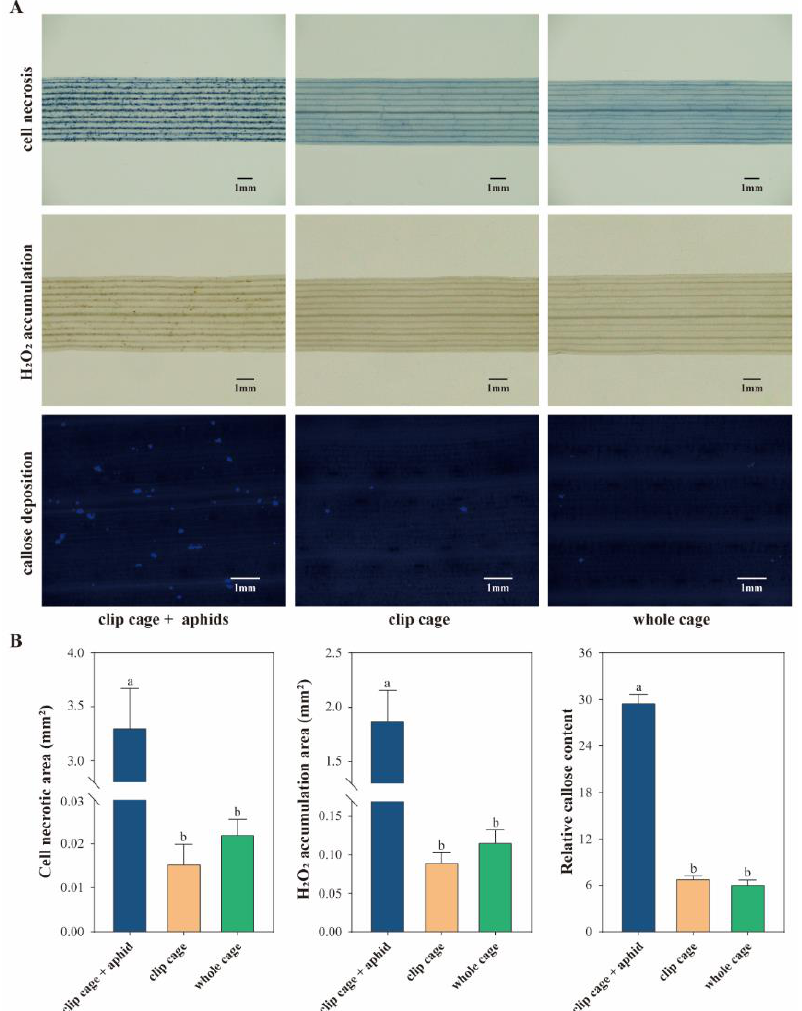
Figure 6. Sitobion avenae , but not the clip cages, significantly affected cell necrosis, hydrogen perox- ide accumulation, and callose deposition. ( A ) Wheat leaves stained with trypan blue, 3,3′ -diamino- benzidine, and aniline blue after being covered in different cages. ( B ) Cell necrotic area, hydrogen peroxide content, and relative callose content quantified using ImageJ software ( n > 11). Different letters indicate significant differences at p < 0.05 level (one-way ANOVA, and Games –Howell’s mul- tiple comparisons test).